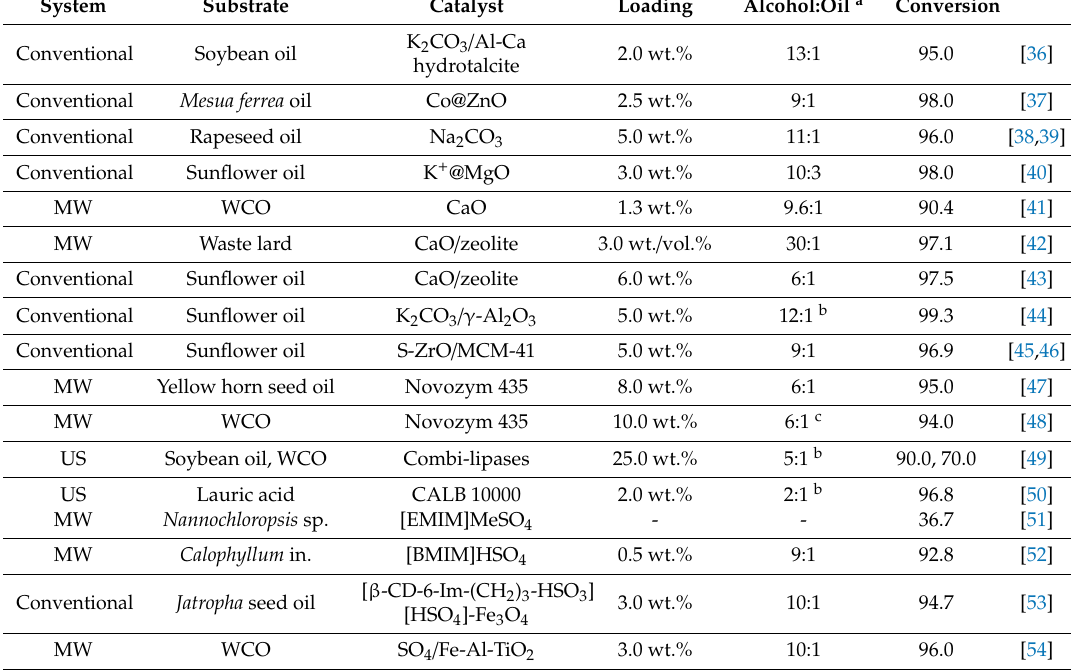
Table 4. Innovative catalysts for biodiesel